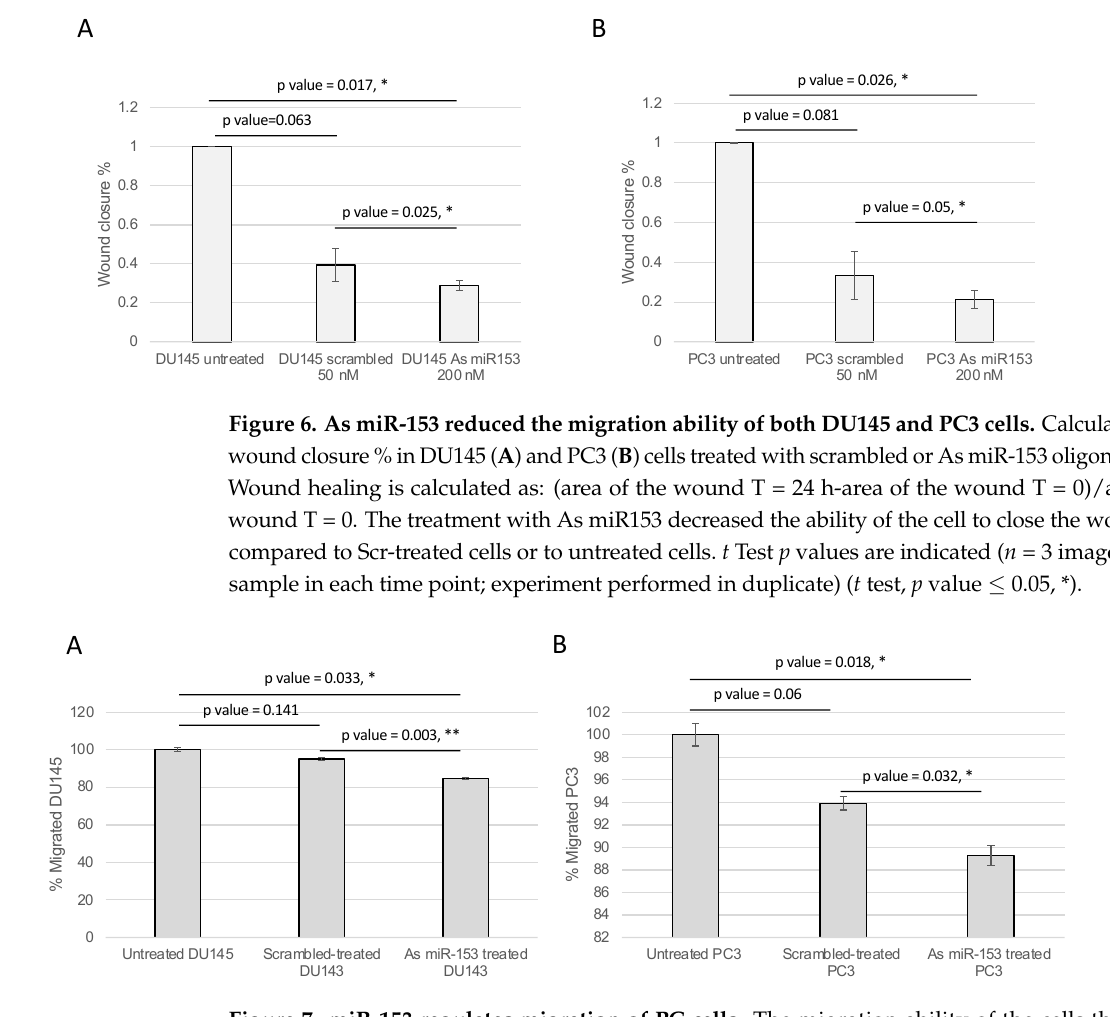
Figure 7. miR-153 regulates migration of PC cells. The migration ability of the cells through the Boyden’s chamber was significantly affected by As miR-153 treatment, compared to both untreated and scrambled-treated cells, in DU145 ( A ) and PC3 ( B ) cells. t test p values are indicated (quantifica- tion of migrated cells in n = 4 images for each sample at 24 h of treatment; experiment performed in duplicate) ( t test, p value ≤ 0.05, *; 0.01,